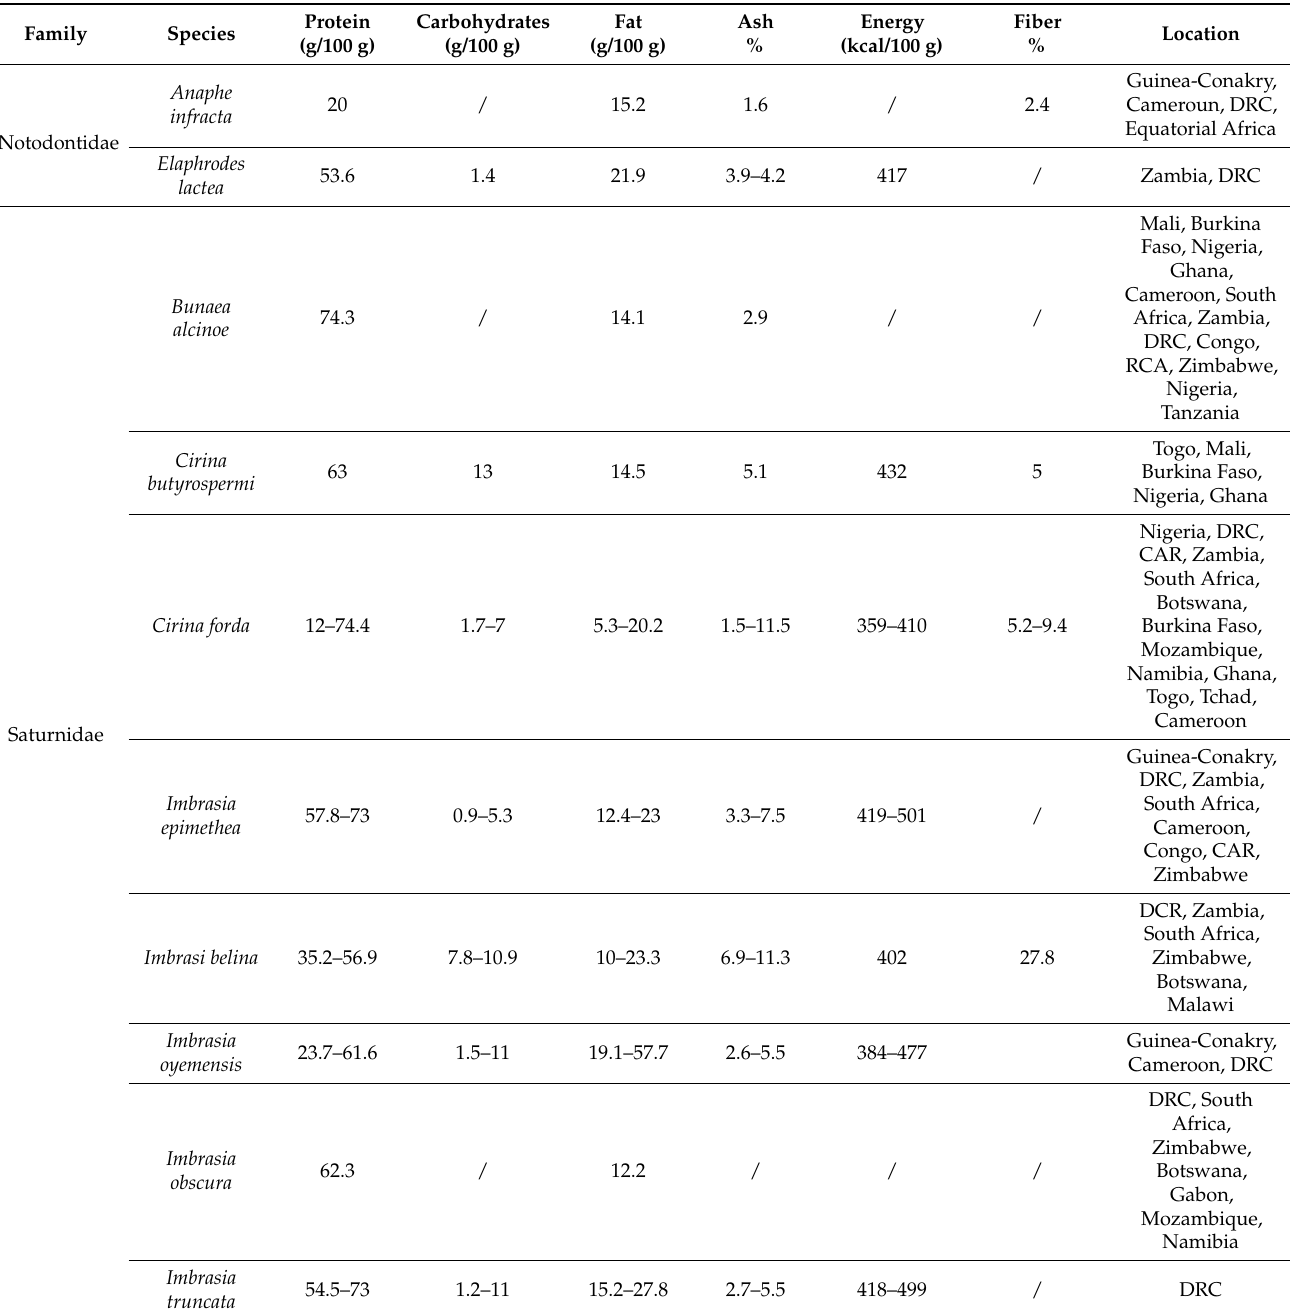
Table 3. Nutritional composition of edible caterpillars consumed in Africa (dry matter